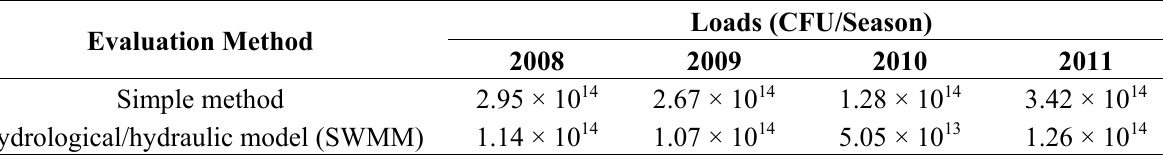
Table 10. FC loads estimated by two methods for the 1 May to 31 August